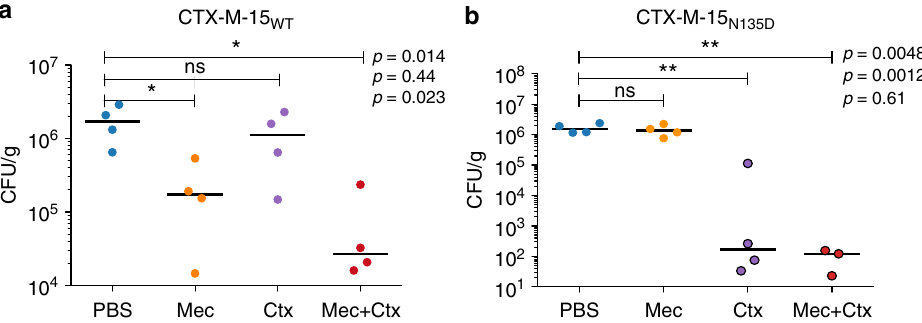
Fig. 4 Bacterial counts from mice infected with CTX-M-15WT or CTX-M-15N135D after treatment. Mice infected via intraperitoneal injection with S. typhimurium expressing either CTX-M-15WT strain ( a ) or the mutant strain carrying CTX-M-15N135D ( b ) were treated with mecillinam (Mec), cefotaxime (Ctx), or a combination of the two. PBS was used as a negative control. Bacterial counts of liver tissue (colony-forming units (CFU)/g) are shown (four mice per group). Inoculum size was 1.5 × 105 CFU/mouse. ns: not signi fi cant; * p < 0.05; ** p < 0.01. Horizontal bold line denotes the median. Statistical analysis was performed using unpaired Student ’ s t -test. Symbols surrounded by a black border represent counts on plates with < 20 CFU (in those cases, statistical signi fi cance was calculated assuming 20 CFU/plate). One mouse infected with the mutant CTX-M-15N135D and treated with mecillinam in combination with cefotaxime cleared the infection. Data from this mouse are not